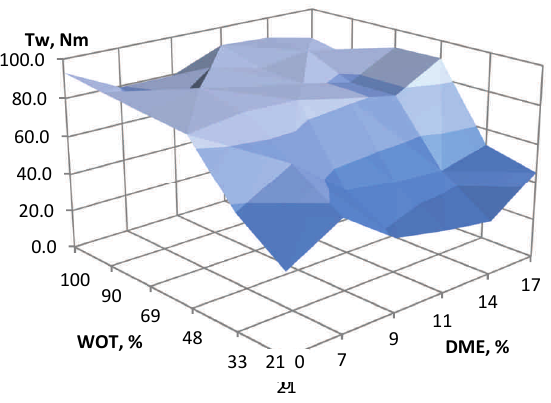
Fig. 10. The results of torque on wheel measured during experimental test; n = 2500 rpm 3.2. In-cylinder pressure and combustion process The observed changes are apparently evident in the analysis of the phenomena occurring in the combustion chamber. In the graph showing the maximum values of the indicated pressure (Fig. 11), it can be seen that at the full engine load the highest pressure values were obtained